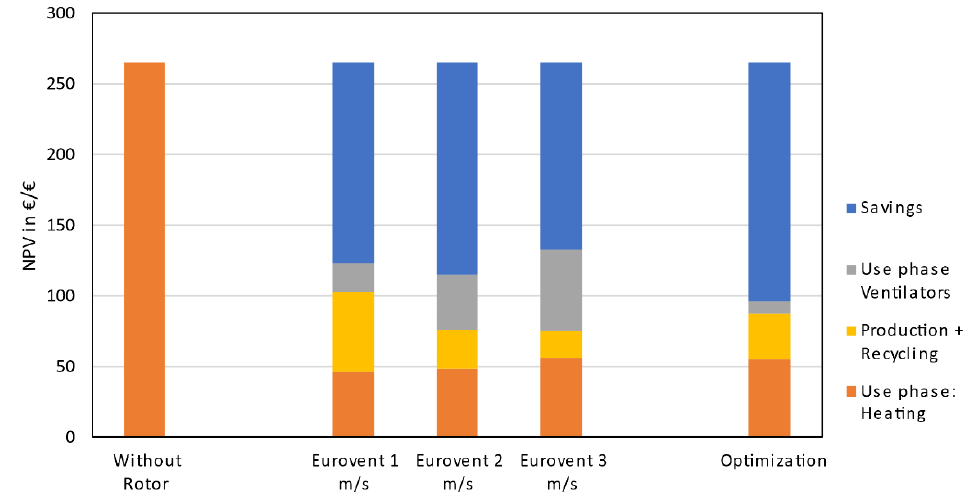
Figure 8. Scenario 0 €/t CO 2 Eq. with optimized RHX and Eurovent RHX under different operating ambient air empty tube velocities at 100,000 m 3 /h.